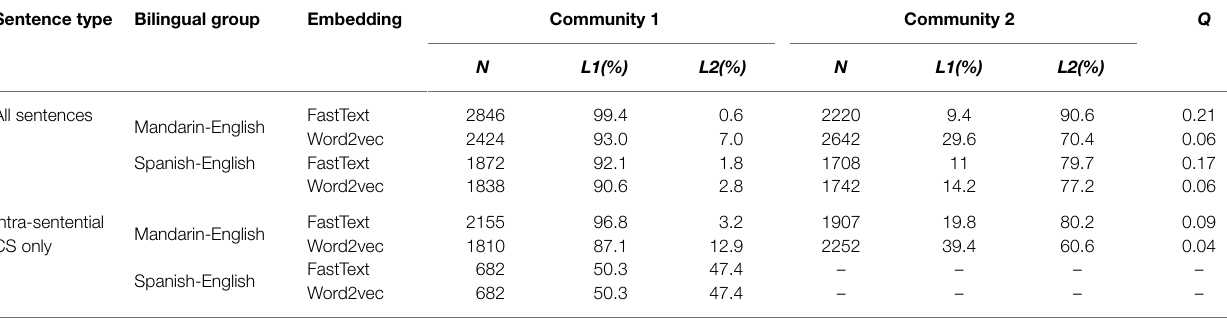
TABLE 3 | Community detection